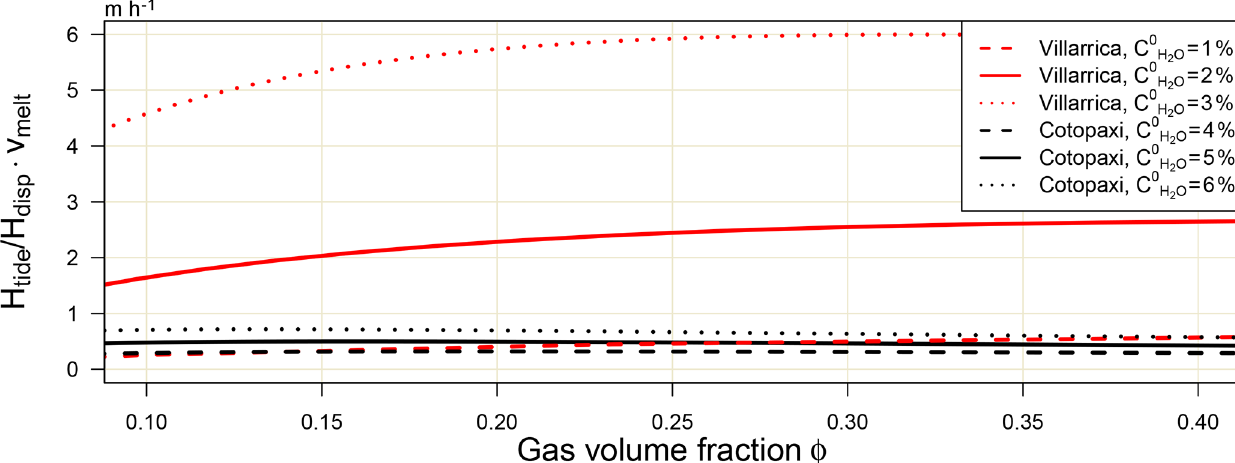
Figure 3. Relative contribution of the tidal mechanism (magnitude given by H tide ) on the bubble coalescence rate for a purely dispersed bubble flow (magnitude given by H disp ) depending on the gas volume fraction and the initial water weight fraction of the magmatic melt. The corresponding values for φ are calculated with Eq. (5) assuming an ideal gas and magma temperatures of 1200 ◦ C for Villarrica and 1000 ◦ C for Cotopaxi. The relative tidal contribution is displayed as the equivalent to an enhancement of the magma ascent rate, which would have the same effect on the bubble coalescence rate. The model increasingly loses validity above the percolation threshold of φ perc ≈ 0 .